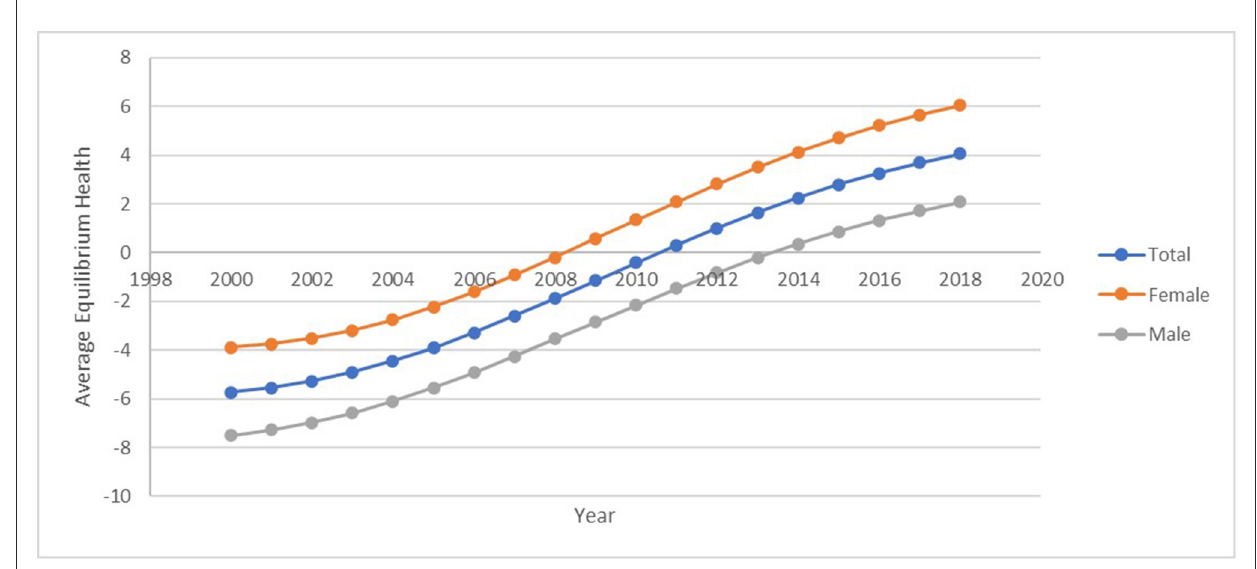
FIGURE3 Average health gap –Africa. Source: Data used in computing the health gap was obtained from the World